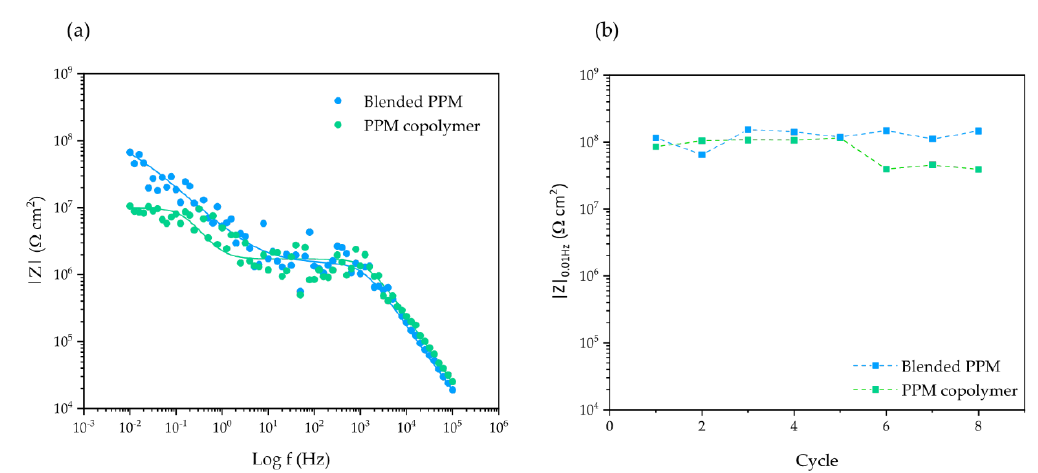
Figure 4. Evolution of Bode modulus plot in ACET experiments during the last cycle ( a ); the fitted data are represented by lines while the experimental values are represented by circles. Evolution of |Z| 0.01Hz over the whole ACET cycles ( b ); dotted lines represent a guide for eye only. In both graphs: 50 μm coating of PPM copolymer (green) and of blended PPM (blue). Coherently, for the entire duration of the ACET, the coating capacitance (Figure 5) of both systems (proportional to the water uptake) exhibits an almost stable value around 0.1 nF cm − 2 (Figure 5). The only exception to the stable trend is the sudden increases in capacitance during the 4th and 7th cycle for PPM copolymer and blend, respectively. Those, coatings invariably restore their C c to the original values in the subsequent cycle.